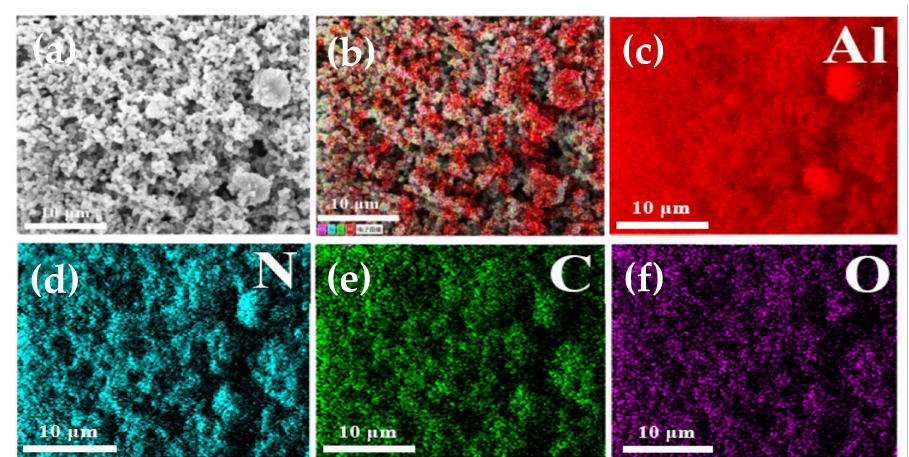
Figure 8. EDS diagram of block copolymer modified AlN powder: ( a ) Original EDS diagram; ( b ) EDS element hierarchy diagram; ( c ) Al element distribution; ( d ) N element distribution; ( e ) C element distribution; and ( f ) O element